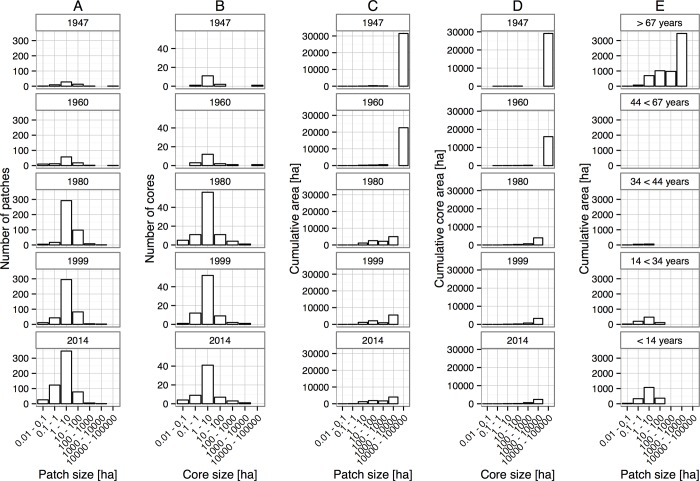
Land use change parameters over five time slices arranged by size class.Column (A) number of patches of forest in each size class; (B) number of core patches (using a 100 m edge buffer) in each size class; (C) cumulative forest area grouped by size class; (D) cumulative core forest area (using a 100 m edge buffer) grouped by size class; and (E) age classification of forest patches present in 2014 and grouped by size class.